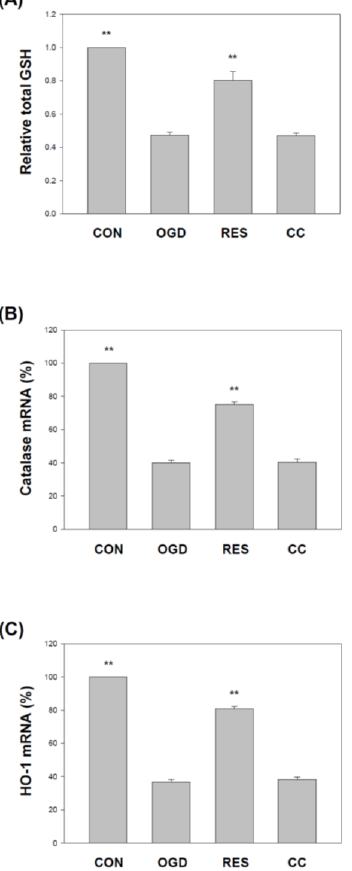
Figure 11. Resveratrol normalized GSH levels, catalase, and HO-1 gene expression by OGD in 3D scaffolds. The cell experiments under the scaffolds were divided into four groups, as described in Figure 1 and the methods section. GSH levels were detected using the Glutathione Colorimetric Assay Kit ( A ). qPCR was used to analyze each treatment group ’ s catalase ( B ) and HO-1 ( C ) mRNA levels. Values are expressed as percentages of the indicated level in CON and are presented as the mean ± SEM values from three independent experiments. Specific comparison to the indicated SH-SY5Y cells with OGD ** p < 0.001 vs. cells with